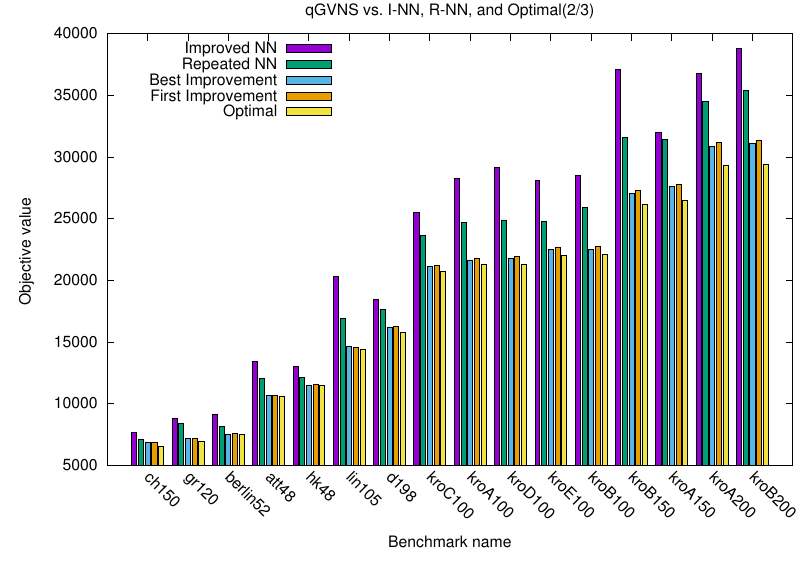
Figure 5. NN variants vs. GVNS vs. OV